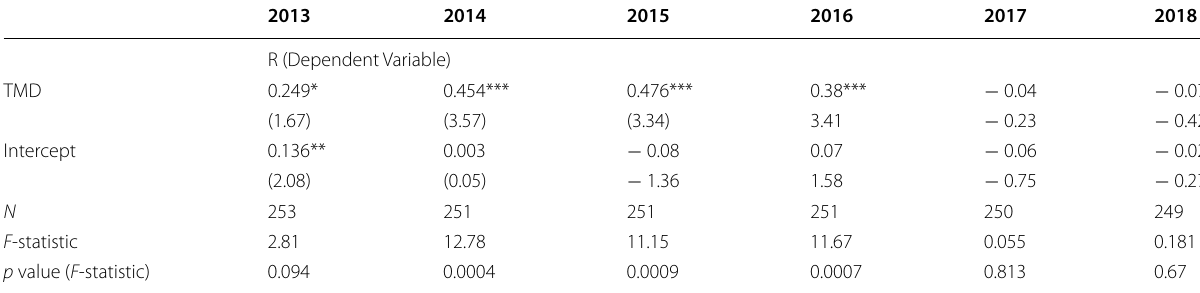
Table 10 Linear regression